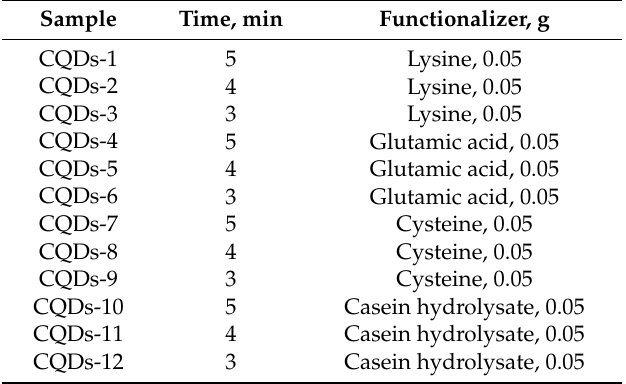
Table 1. Chitosan-based CQD synthesis and functionalization parameters.